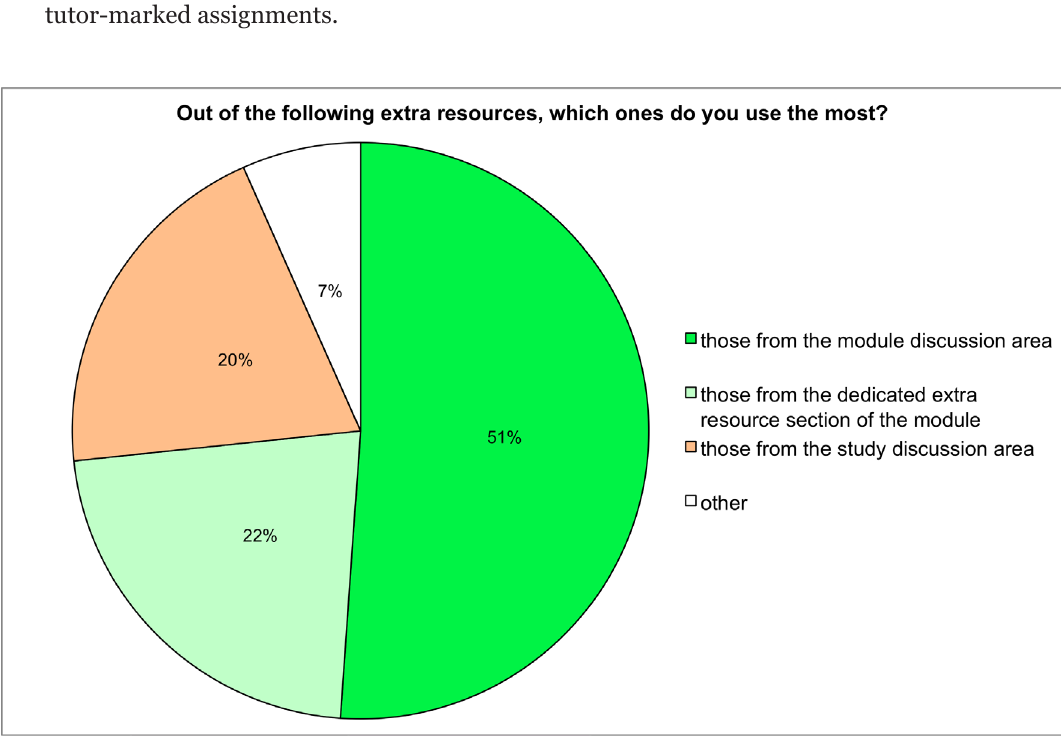
Figure 6 . Student use of extra resources depending on their type and